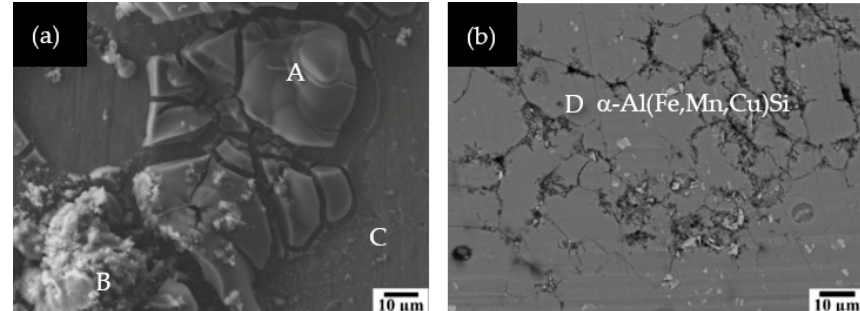
Figure 2. SEM images of AA6061-T6 surface after exposure in Caribbean seawater under laminar flow for 5 days ( a ) and after removal of corrosion layer ( b ). Table 2. EDS analysis (wt.%) of aluminum alloy 6061-T6 surface after 5 days of exposure (zone A, B,